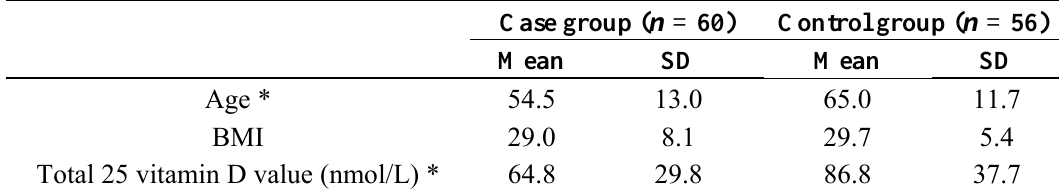
Table 1. Characteristics of participants in Case and Control